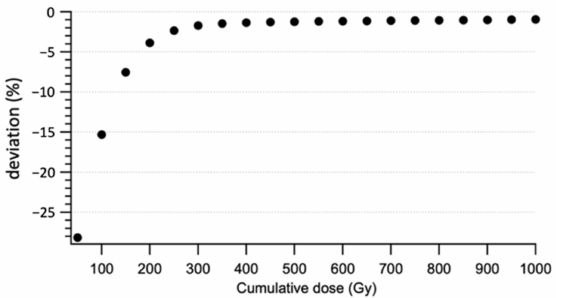
Figure 10. Deviation of IVISCAN ® dosemeter response as a function of cumulative dose. Dose rate deviations were evaluated for each 50 Gy